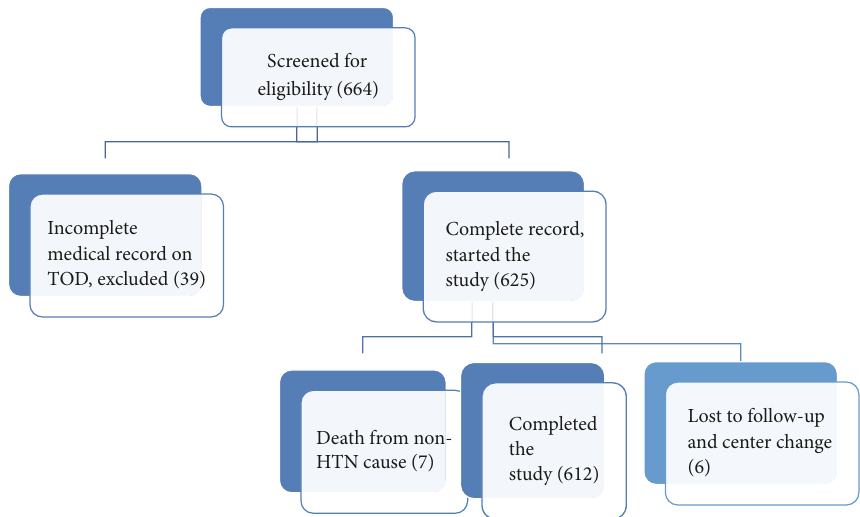
Figure 1: The inclusion of subjects in the cohort